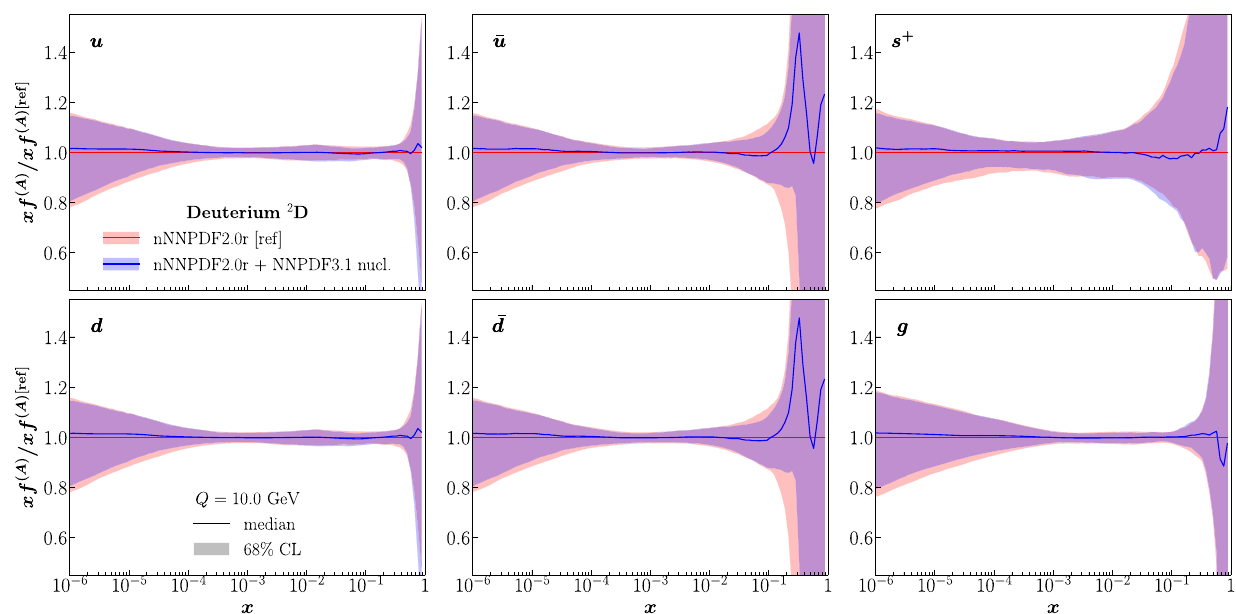
Fig. 21 Comparison of nNNPDF2.0r with the same fit where the deuteron and copper datasets from NNPDF3.1 have been included, see textformoredetails.ResultsareshownforthedeuteriumPDFs( A = 2)